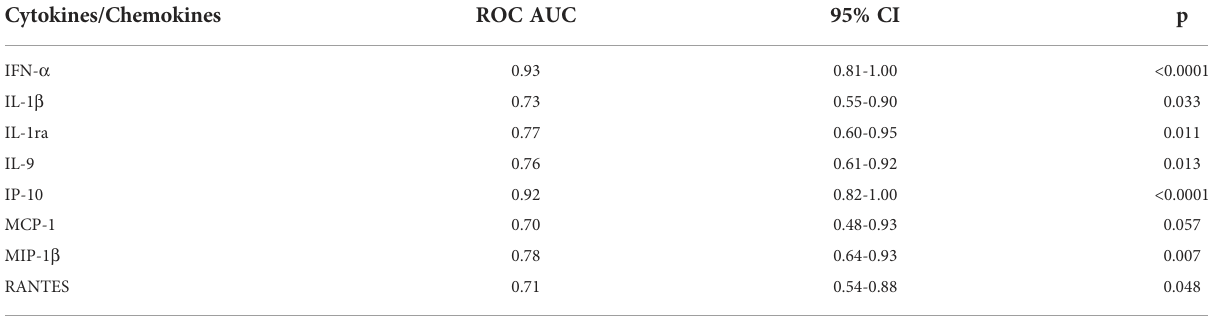
AUC, area under the curve; CI, con fi dence interval.